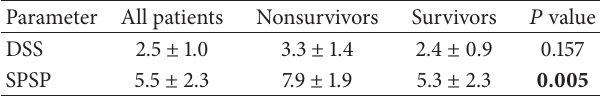
Table 8: SPSP and DSS of patients according to